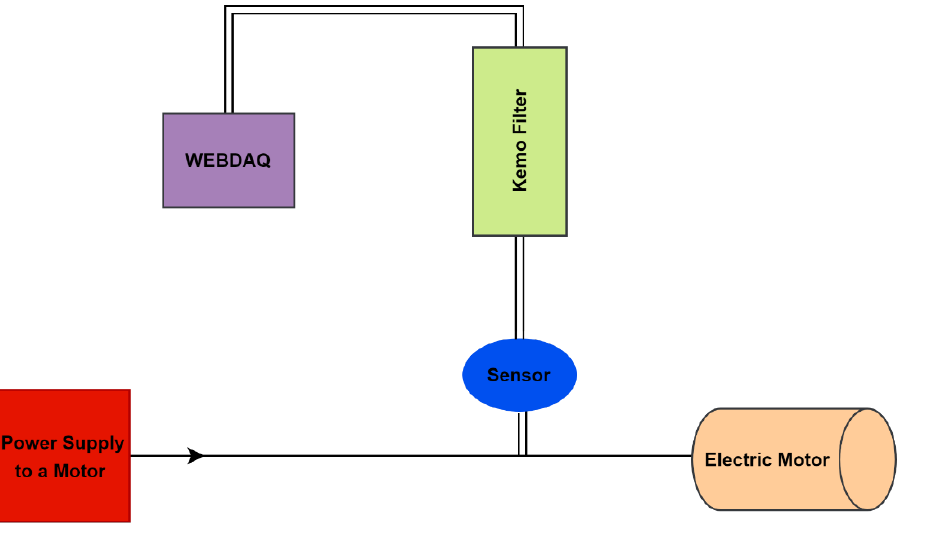
Figure 4. Schematic of the data acquisition system.